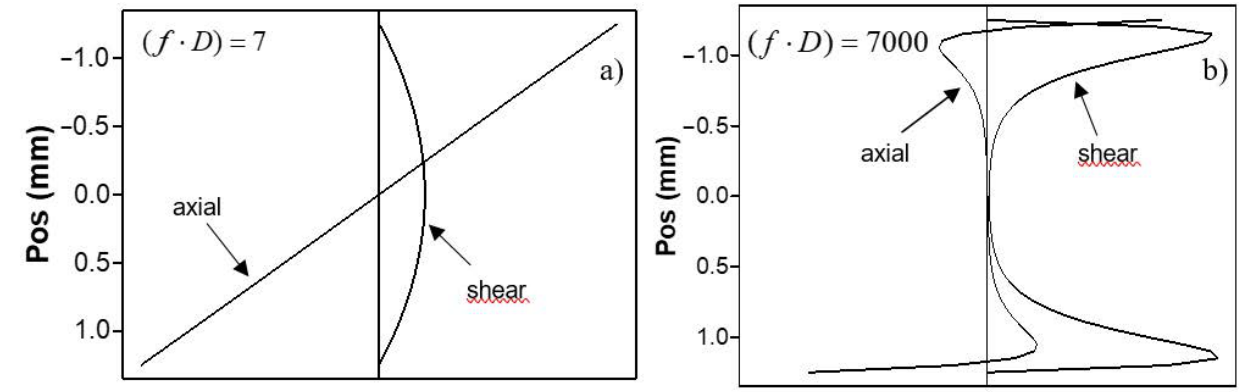
Figure 3. Strain distributions with depth for a 0 mode for different values ( f · D ) (7-( a ), 7000-( b )) in 2.5 mm-thick 90 ◦ -CFRP plate.